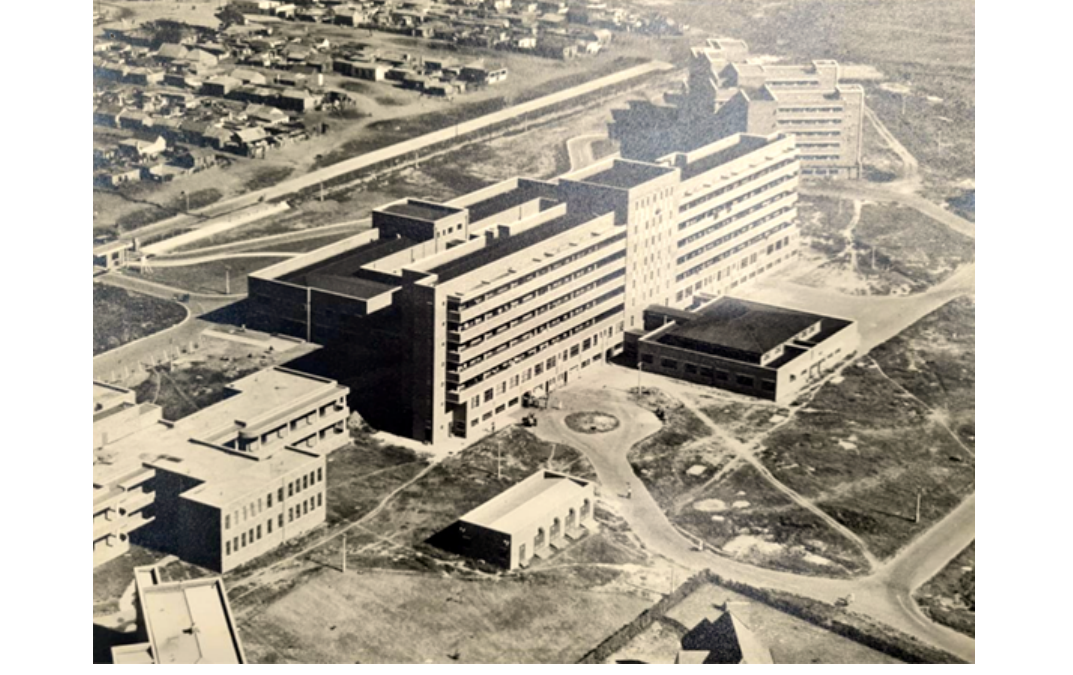
Figure 8. The main ward of the Livingstone Hospital, East London (Source: B. Brinkman, with